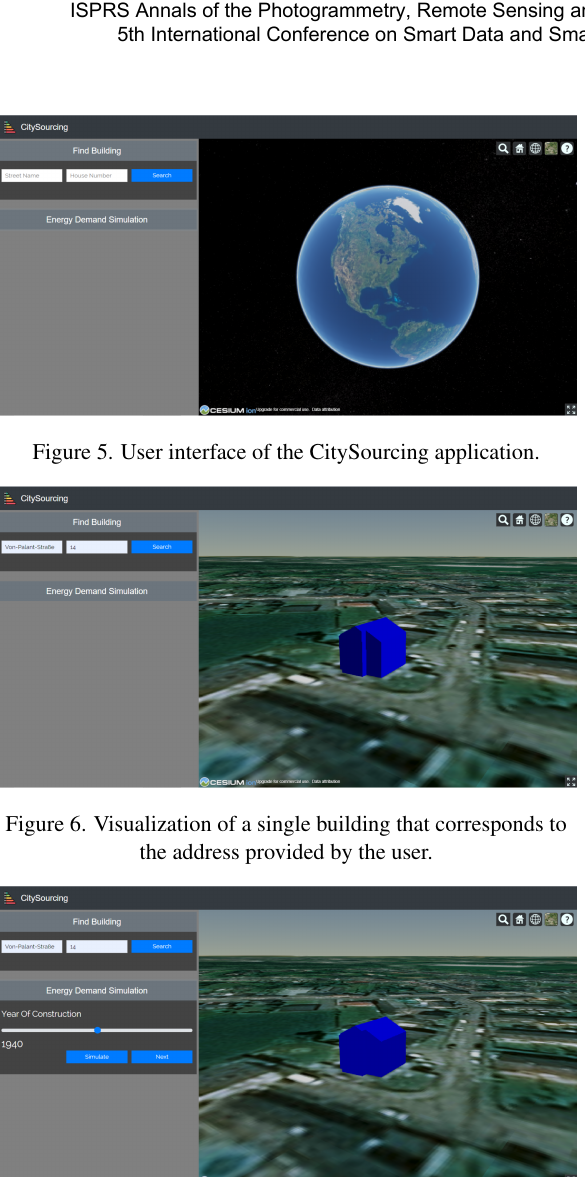
Figure 7. An example a multi-option form providing input information required for energy simulation.